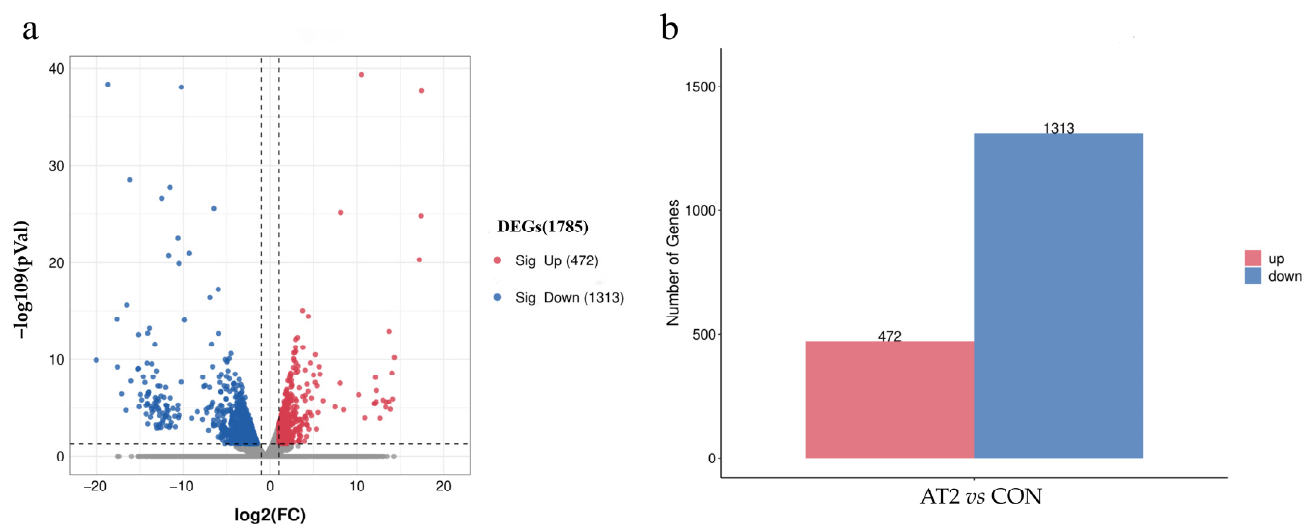
Figure 4. ( a ) Volcano plot of differentially expressed genes (DEGs) between the control group and AGPAT2 knock-down group. ( b ) Histogram of differentially expressed genes (DEGs) between the control group and AGPAT2 knock-down group.